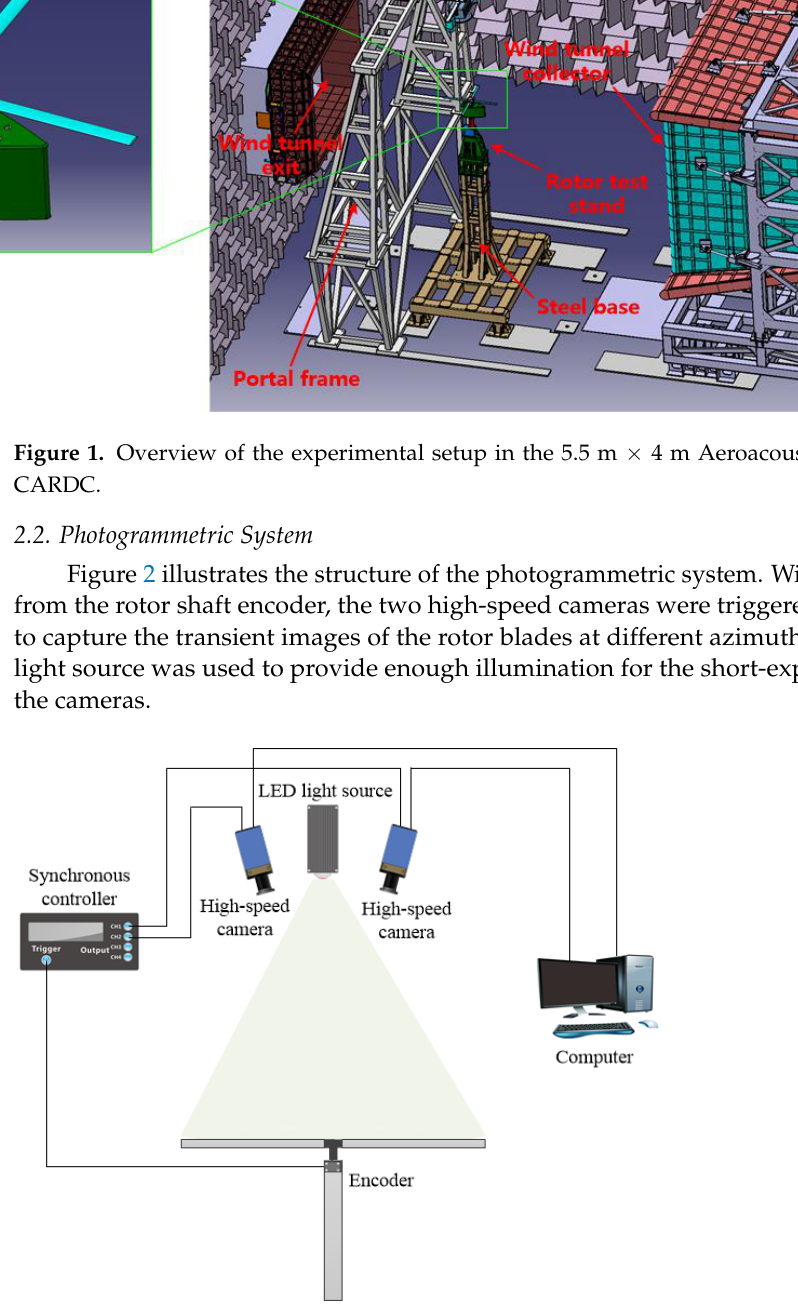
Figure 2. Structure of the photogrammetric system.